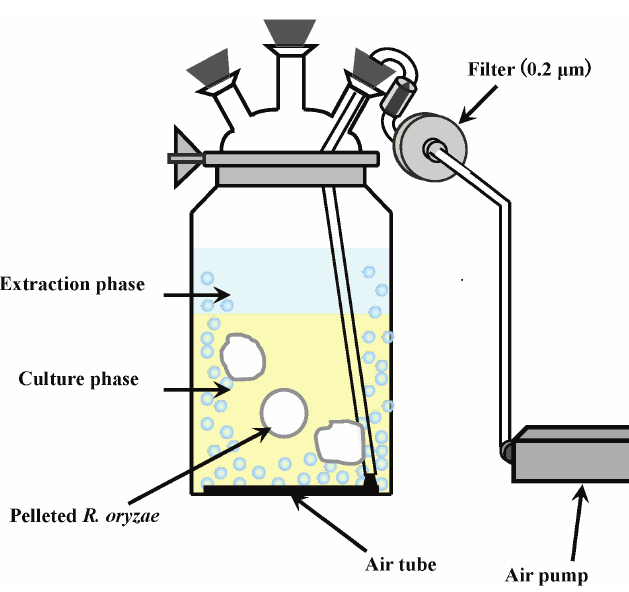
Fig. 1 – Schematic diagram of extractive fermentation with air-lift